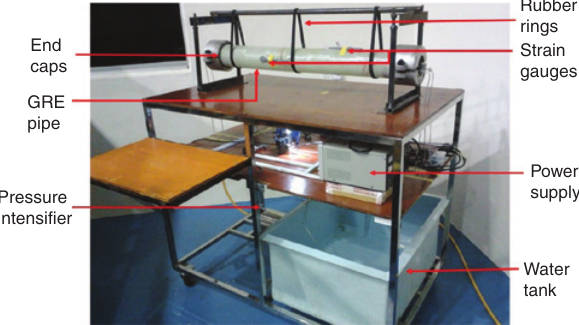
Figure 3: Automated pressure test rig supporting multiaxial loading